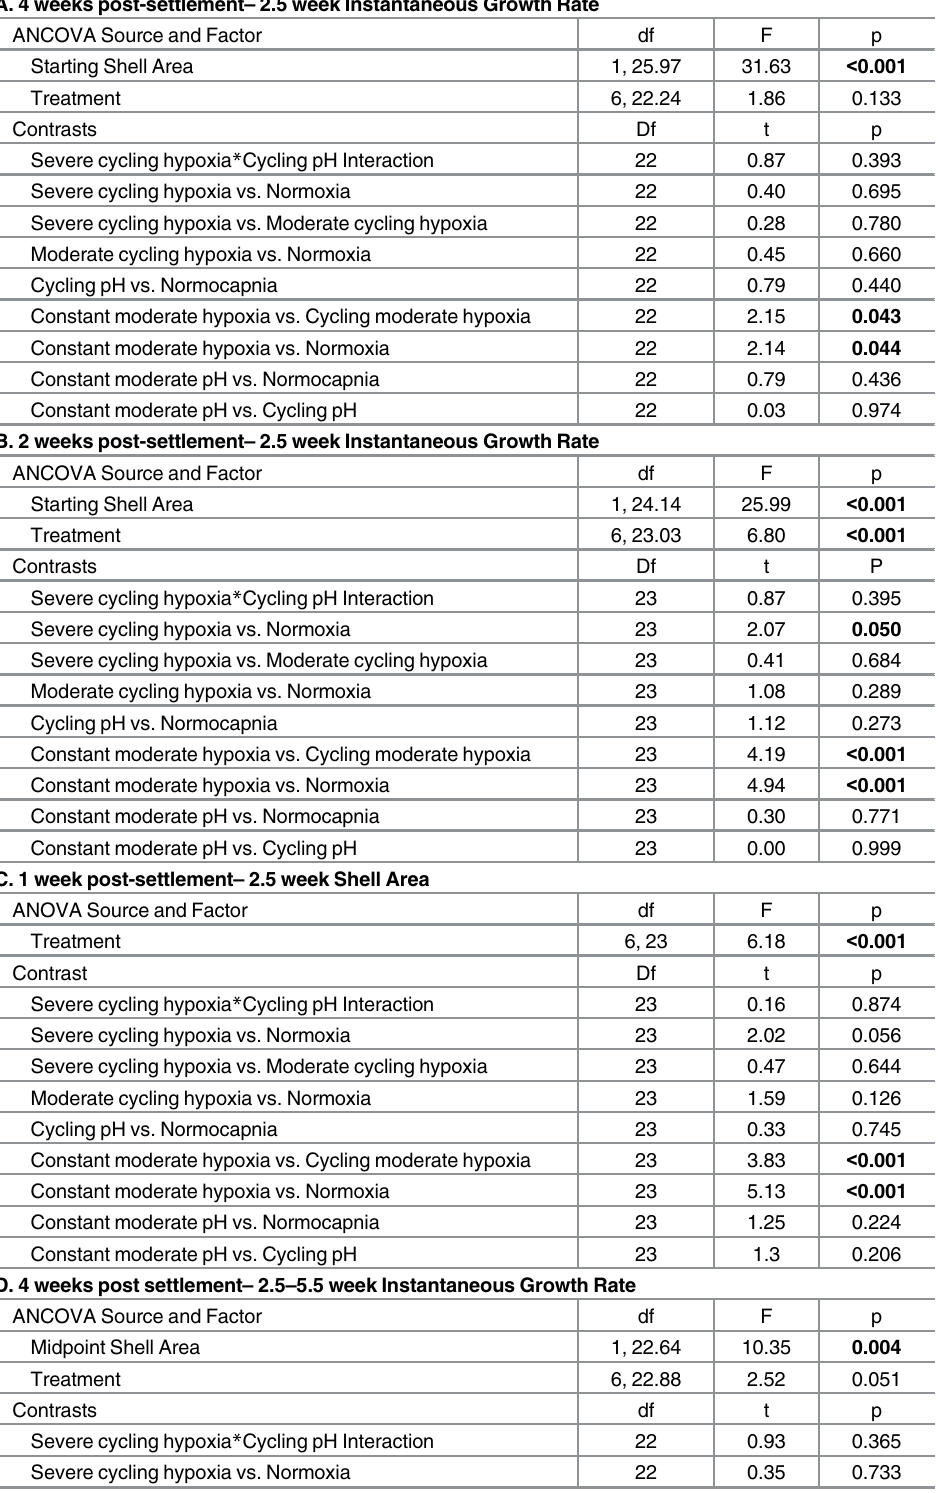
Table 7. 2013 juvenile oyster growth